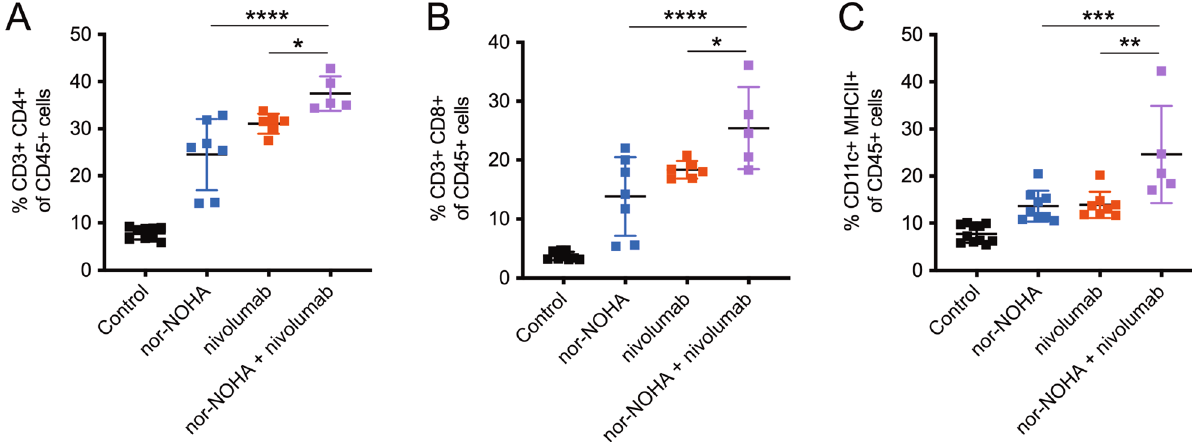
Figure 8. Combination treatment with transcutaneous arginase inhibition and systemic PD-1 inhibition is associated with increased recruitment of intratumoral T cells and dendritic cells than either treatment, alone. ( A ) Percentage of intratumoral CD45 + leukocytes that are CD3 + CD4 + , indicating tumor-infiltrating CD4